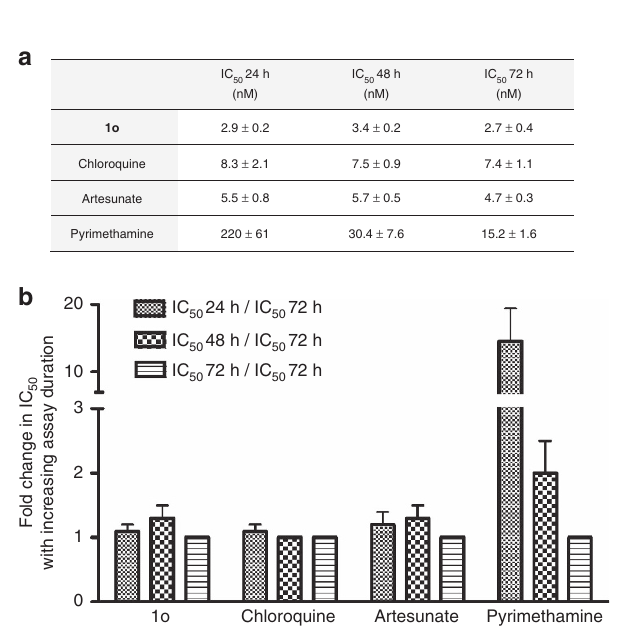
Figure 2 | IC 50 values of 1o and established antimalarial drugs as determined in the IC 50 speed assay on P. falciparum NF54 in vitro 18 . ( a ) Provided are mean values ± s.d. from three biological replicates. ( b ) The fold change in IC 50 over time is indicated, showing that only pyrimethamine is a slow-acting